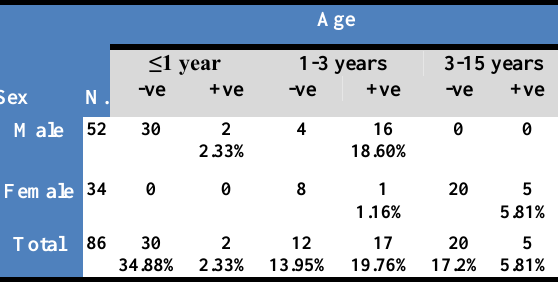
Table, 6: Age and Number of tested slaughtered